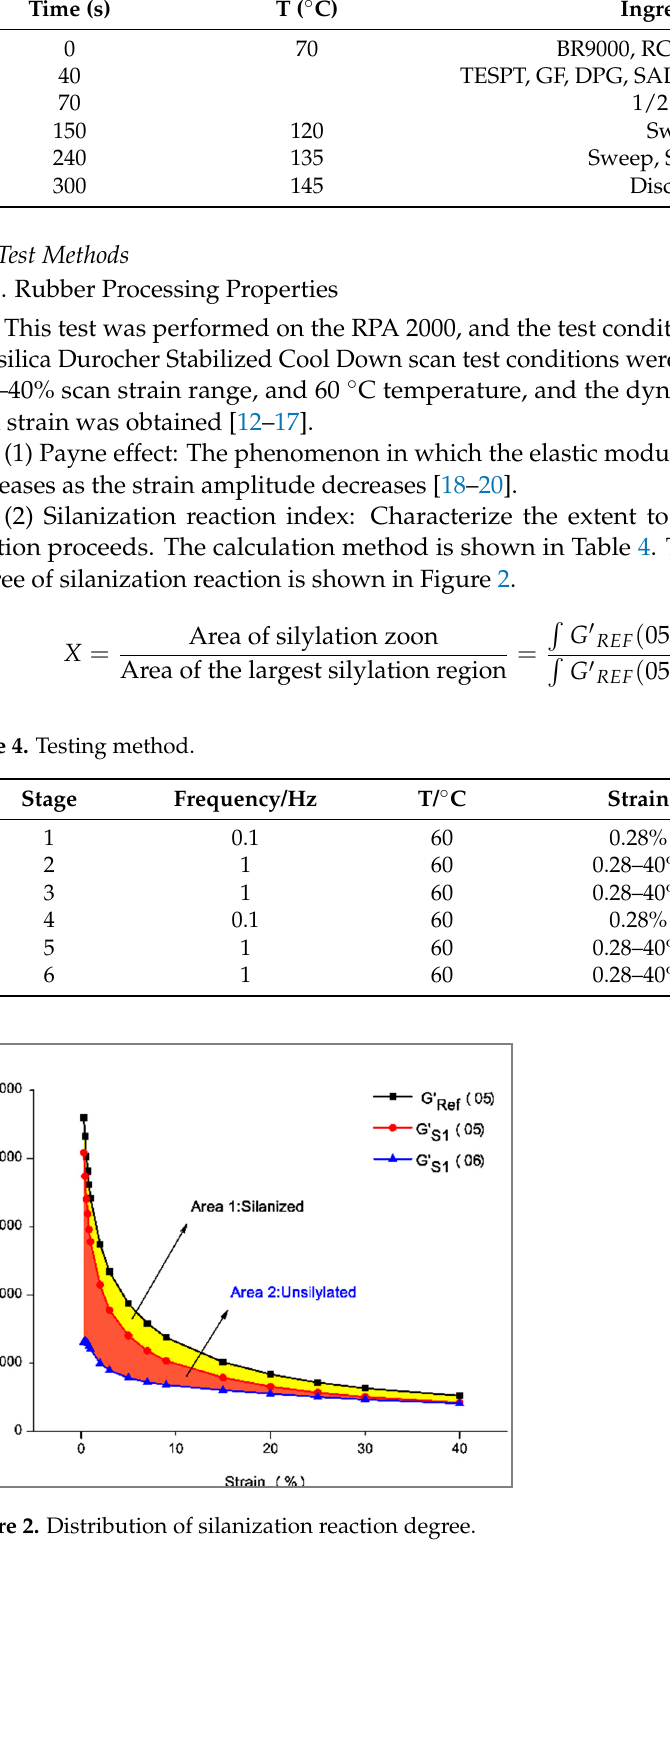
Figure 3. Hake internal mixer. The CSM was parameterized before the experiment. The rotation speed of the CSM was the same as that of the Hake mixer, which was set to 70 r/min, the pressure was set to 5 N, and the friction time of the CSM was set to 30 min. Previous studies have shown that the most severe wear occurs at the end of the experiment, so the CSM temperature was set to 150 °C. The CSM friction and wear tester is shown in Figure 4 [21–25].